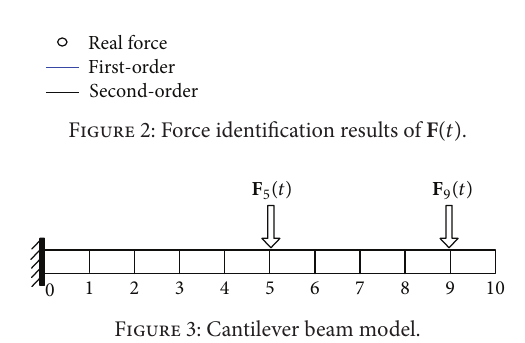
Figure 3: Cantilever beam